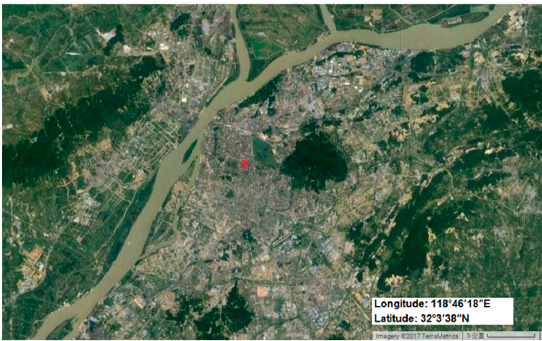
Figure A1. Location of sampling site (red point).